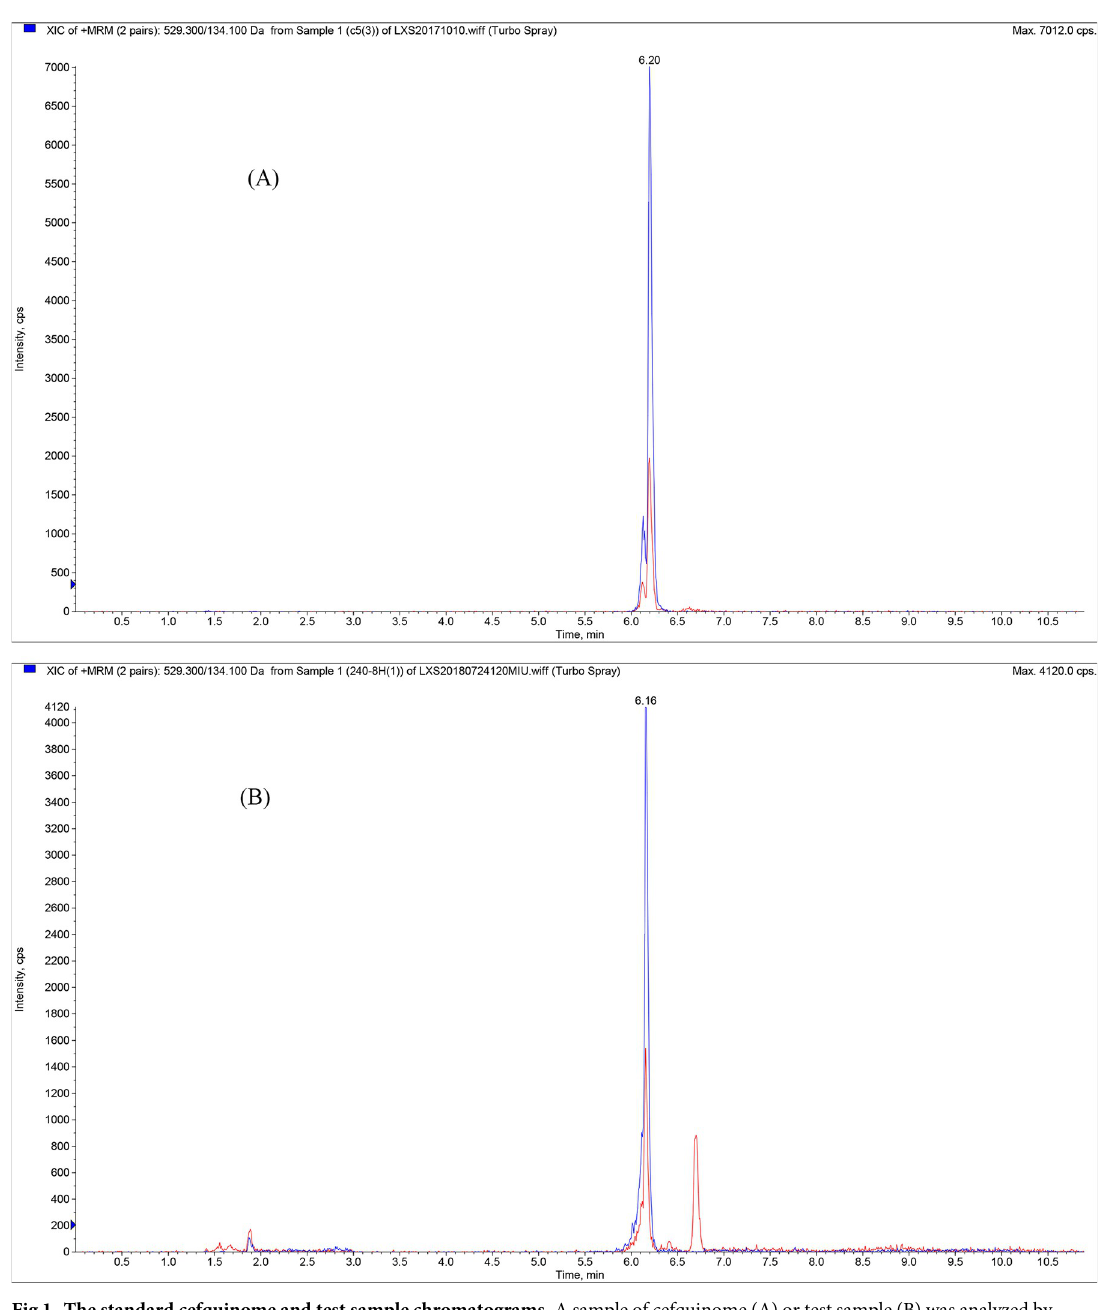
Fig 1. The standard cefquinome and test sample chromatograms. A sample of cefquinome (A) or test sample (B) was analyzed by LC-ESI-MS/MS. For the test sample, cefquinome was extracted as described in the method section and analyzed by LC-ESI-MS/MS (B).